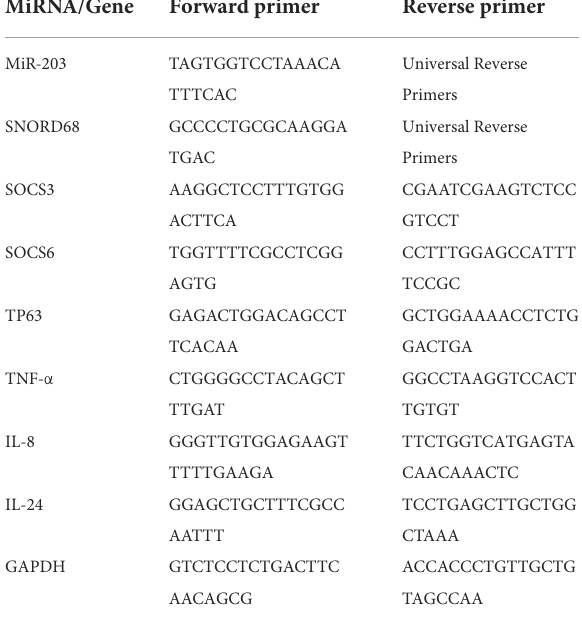
TABLE 1 A list of the qRT-PCR